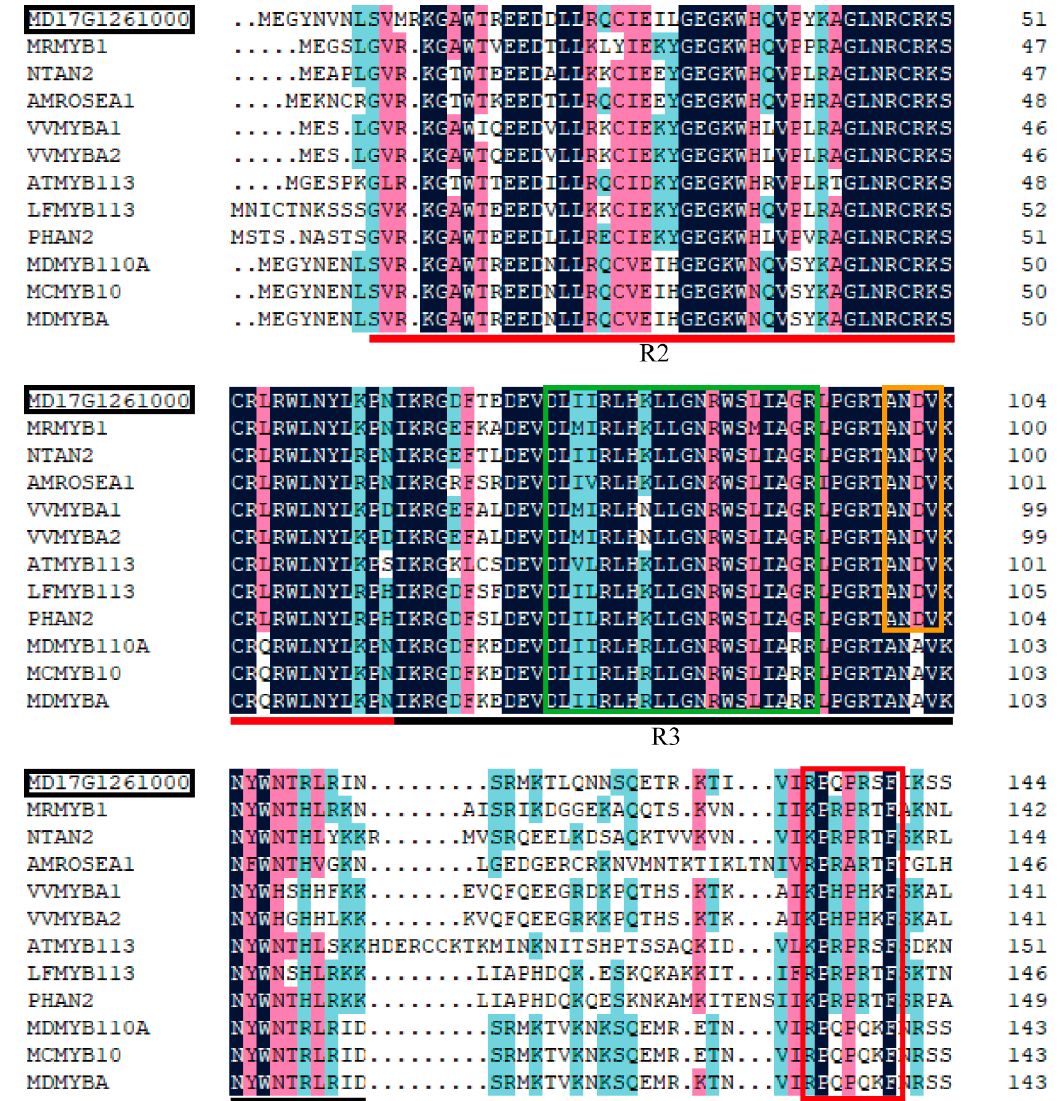
Figure 7. Protein sequence alignment of MD17G1261000 with MYB genes that promote anthocyanin biosynthesis in various plant species. The red line indicates the R2 domain and the black line indicates the R3 domain. The green, orange, and red boxes represent the [D / E]L × 2 [R / K] × 3 L × 6 L × 3 R sequence, the ‘ANDV’ sequence, and motif 6, respectively.